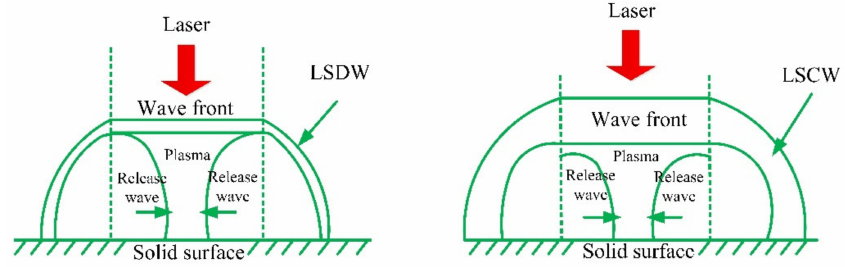
Figure 3. The structure diagram of LSCW and LSDW